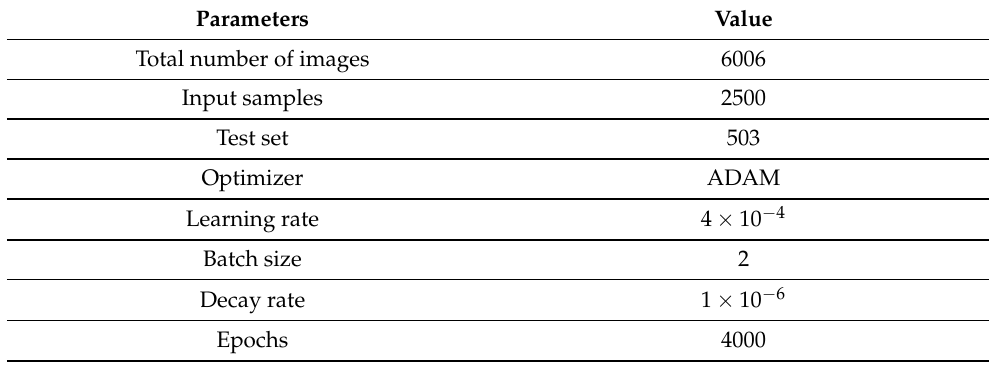
Table 1. Training